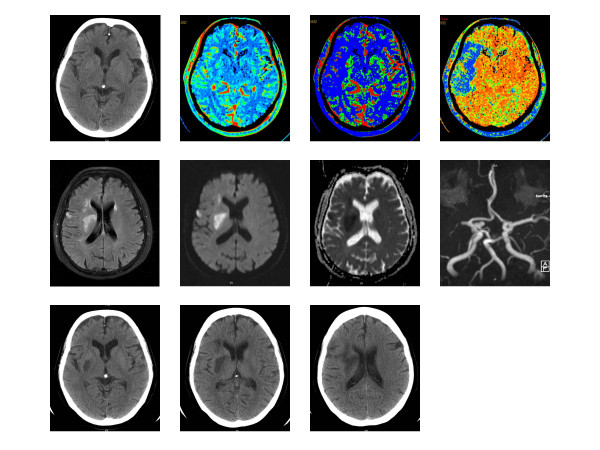
Top row, left: Admission CT showing hypoattenuation of the right lentiform nucleus and insular cortex as well as slight swelling of cortical sulci in the right frontoparietal region. Top row, the third and the fourth pictures: The perfusion CT on admission, with flow and mean transit time CT showing a broad perfusion deficit in the right MCA region. Top row, the second picture: The volume chart shows only a small deficit in the right MCA region, consistent with the presence of a large ischemic penumbra in the cortical cerebral tissue. Middle row: The follow-up brain MRI showing the presence of a limited subcortical infarct on the distal region of the right lentiform nucleus and corona radiata. Signs of only a subtle cortical infarction are seen. From left to right: FLAIR MRI, T2-diffusion-weighted MRI, apparent diffusion coefficient. Middle row, right: The persistence of the right MCA occlusion on the follow up MRA. Bottom row: Day 2 CT showed that the extent of the subcortical infarct was substantially smaller than that of the perfusion deficit found in the CT perfusion brain scan obtained on admission.